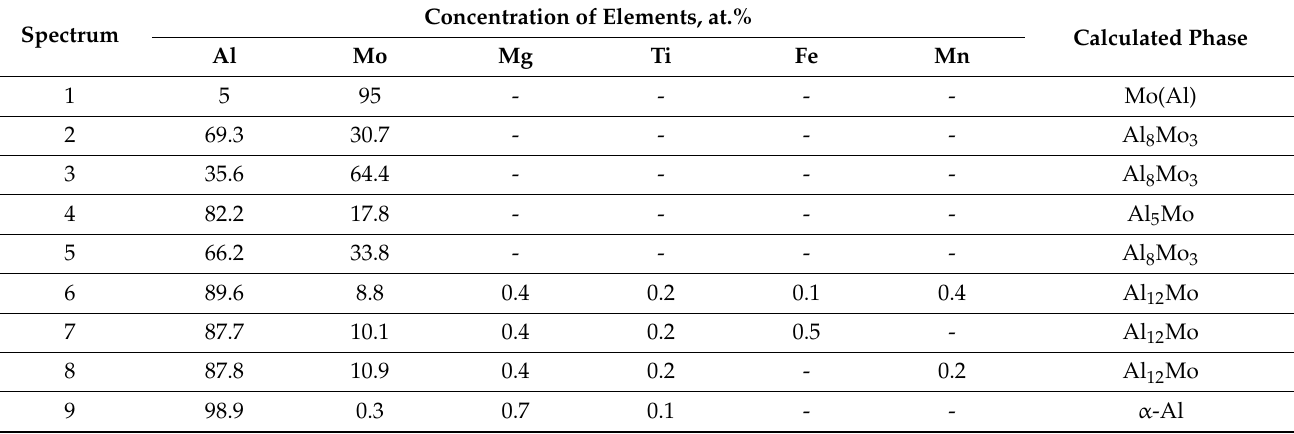
Table 2. EDS analysis of the AA5154/Mo with 0.3 g/layer was obtained by using SEM (Figure 6b,d). Concentration of Elements, at.% Spectrum